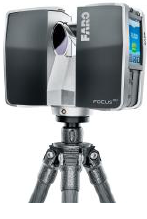
Figure 4. Faro Focus 3D laser